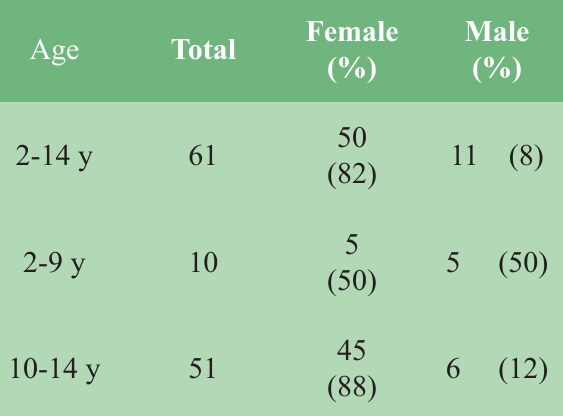
Table 1. Age and sex distribution of Children (n=61)